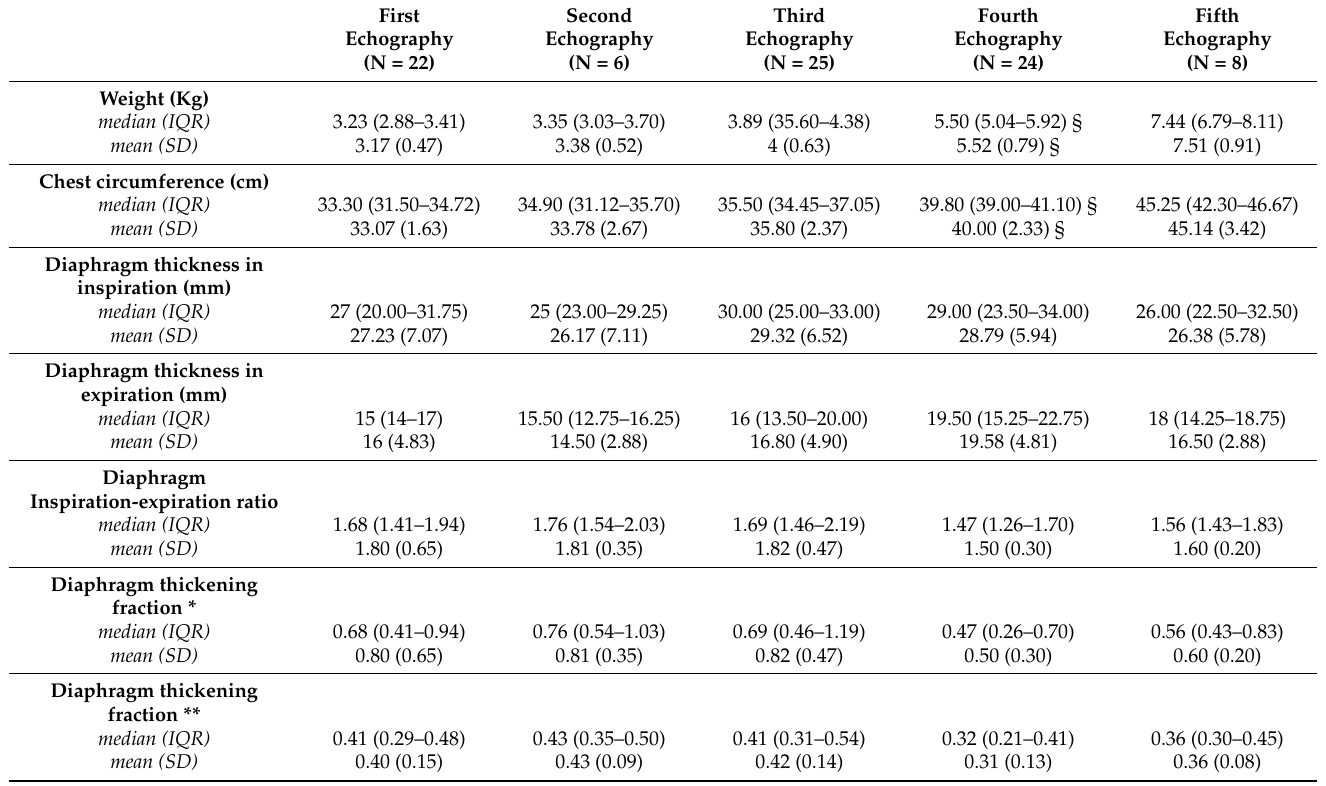
Table 1. Measurements collected during different ultrasound